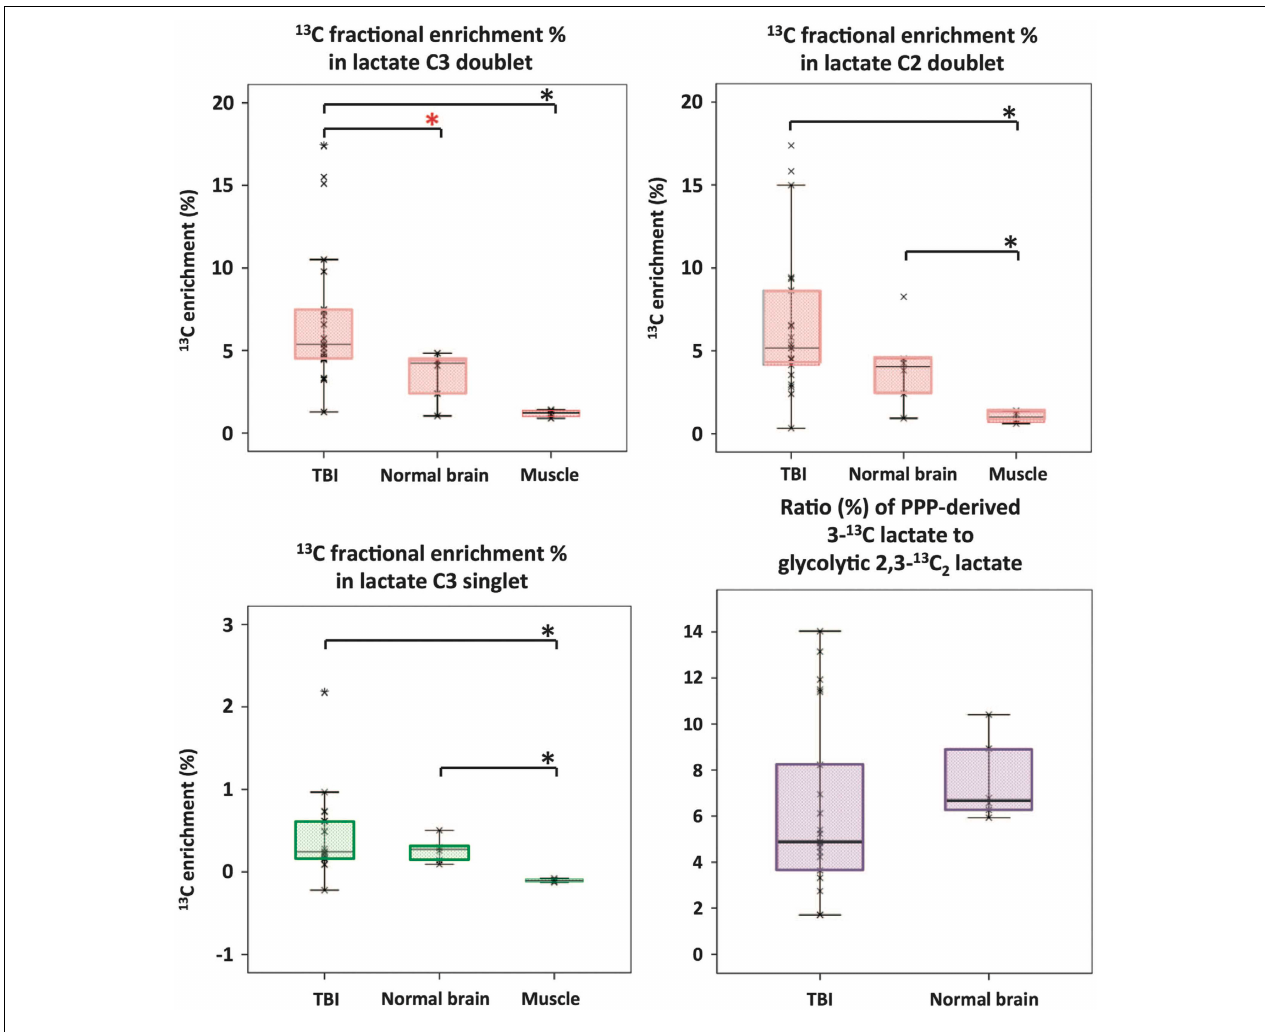
FIGURE 7 | MicrodialysateNMRmeasurementsof 13 Clabeling:results from perfusion for 24-h- (brain: TBI or “normal”) or 8-h perfusion (muscle)with1,2- 13 C 2 glucose(4mmol/L). Redasterisksdenote P < 0 . 01 for TBI vs. “normal” brain (Mann–Whitney); other comparisons asterisked in